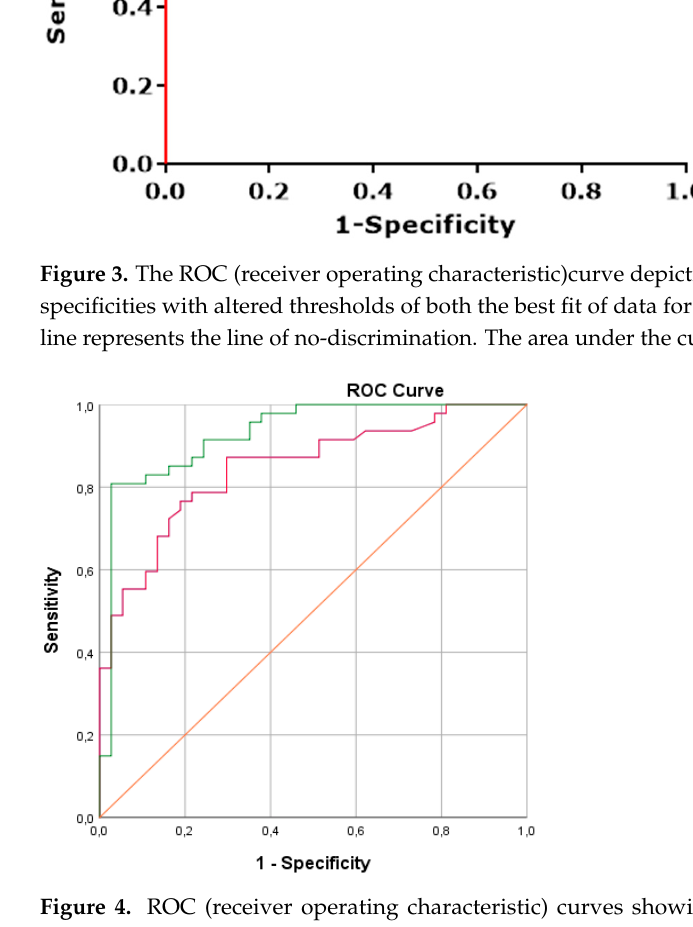
Figure 4. ROC (receiver operating characteristic) curves showing the best fit of data for cross-validation when including in the statistical analysis; the clinical parameters of gender, age, smoking (total pack-year), and toombak use (green line; the area under the green curve is 0.92) are compared to the best fit for cross-validation when only the e-nose test values are analyzed (red line).